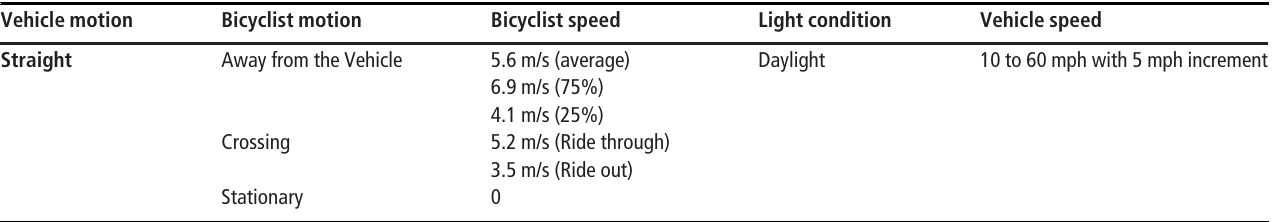
Table XII Scenarios for fi eld testing Vehicle